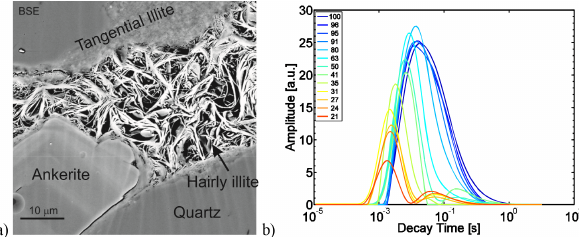
Figure 2. (a) Complex pore structure of a Rotliegend tight gas sand- stone. Pore spaces are filled with tangential and hairly illite and ex- hibit different pore types with elongated or slit-shaped, triangular, and multi-angular cross sections. (b) T 1 decay time distributions calculated from inverse Laplace transform performed on Rotliegend sandstone (porosity 13%, permeability 0.1mD) at different water saturations ( S w =